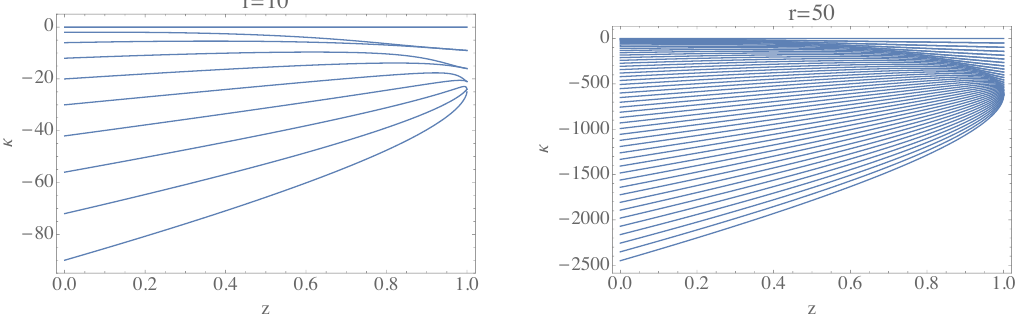
Figure 15 . Plot of values of (cid:20) ( z ) with h (bottom).